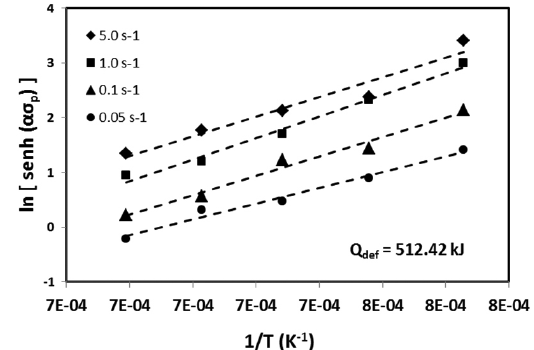
Figure 3. Graph representing the dependence of the peak stress (